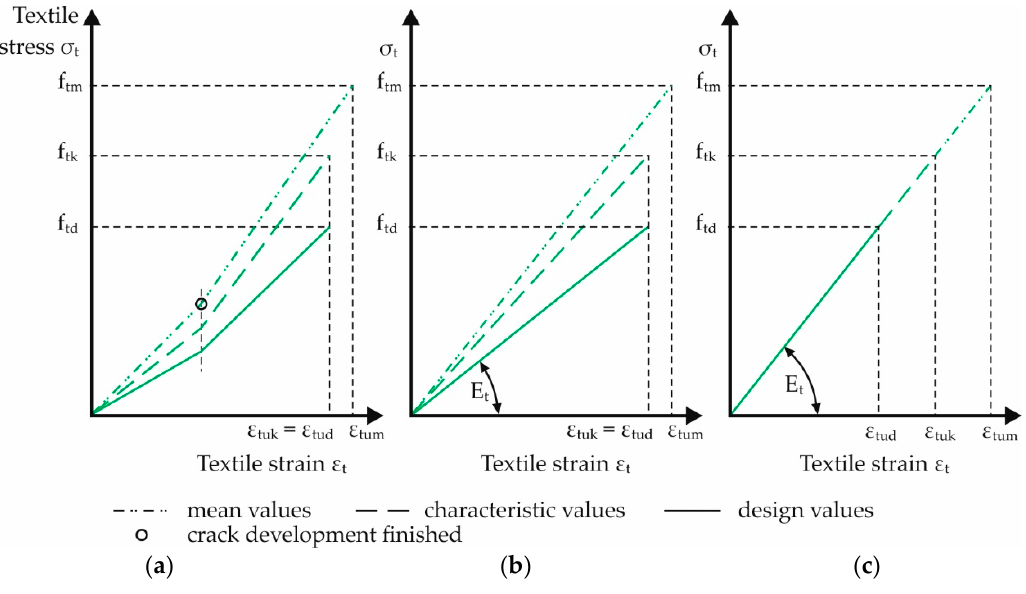
Figure 3. Possible stress-strain relationships for carbon reinforcements: ( a ) variant 1: for textiles with weaker behavior at low stress levels, e.g., because of undulated yarns; ( b ) variant 2: for textiles with linear stress–strain behavior (variable modulus of elasticity); ( c ) variant 3: for materials as in ( b ), constant modulus of elasticity.